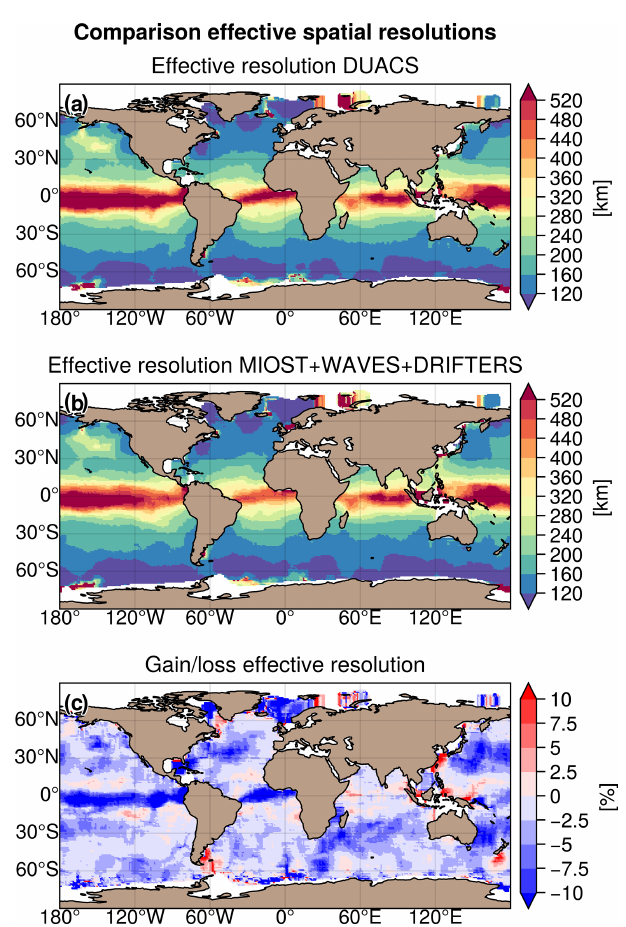
Figure 14. Maps of effective spatial resolution (in km) for (a) the DUACS allsat-1 and (b) MIOST allsat-1 80% drifters + equatorial waves + L3 Arctic experiments and (c) gain/loss of effective reso- lution (in %) between MIOST and DUACS. Blue means finer reso- lution in MIOST than in